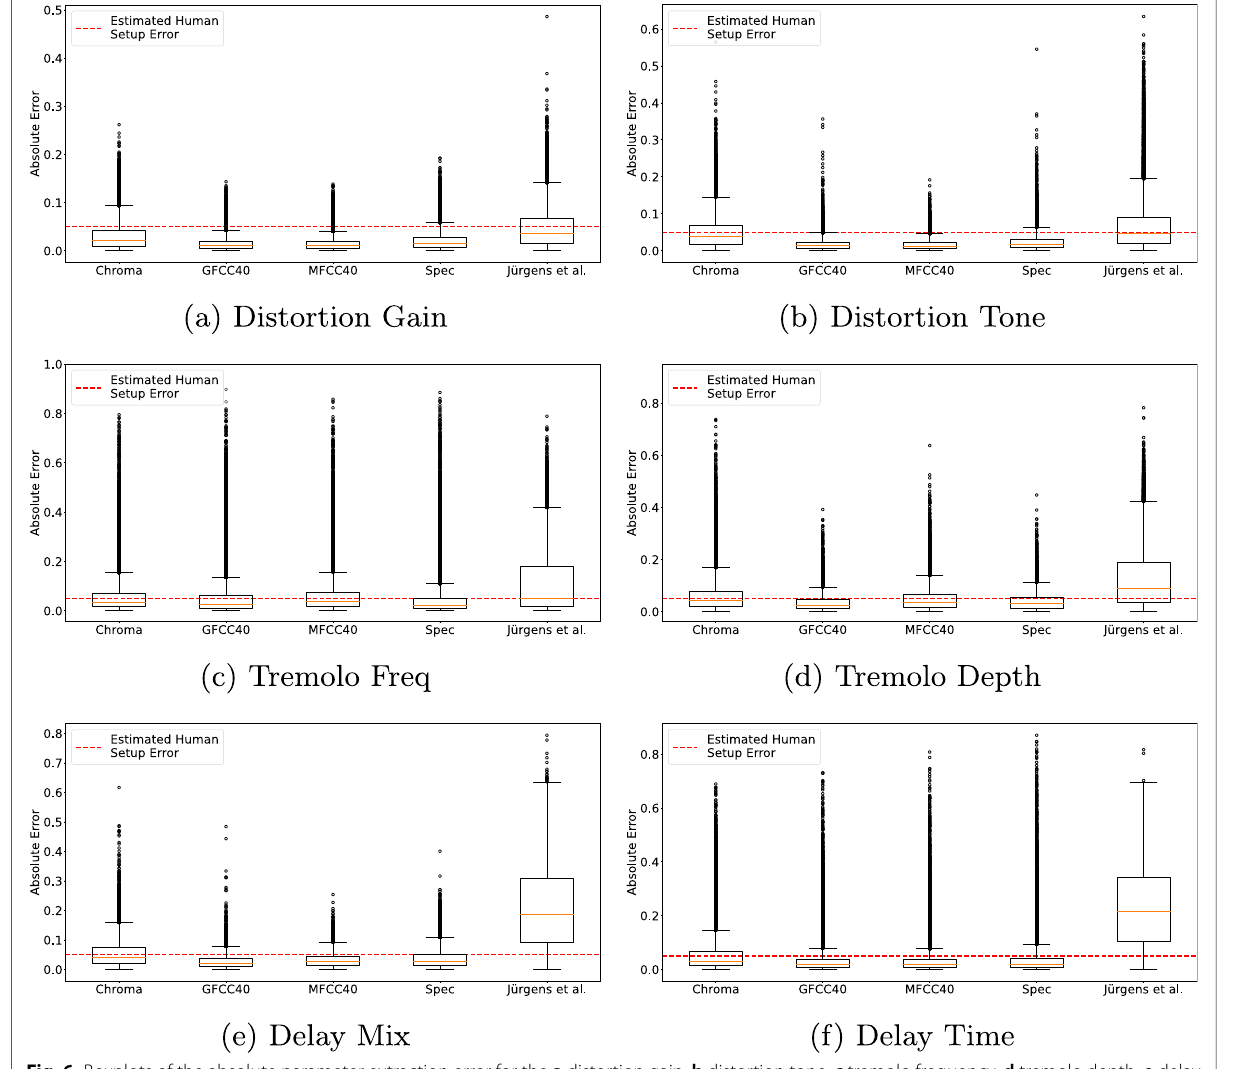
Fig. 6 Boxplots of the absolute parameter extraction error for the a distortion gain, b distortion tone, c tremolo frequency, d tremolo depth, e delay mix, and f delay time parameter for all investigated methods across all volumes